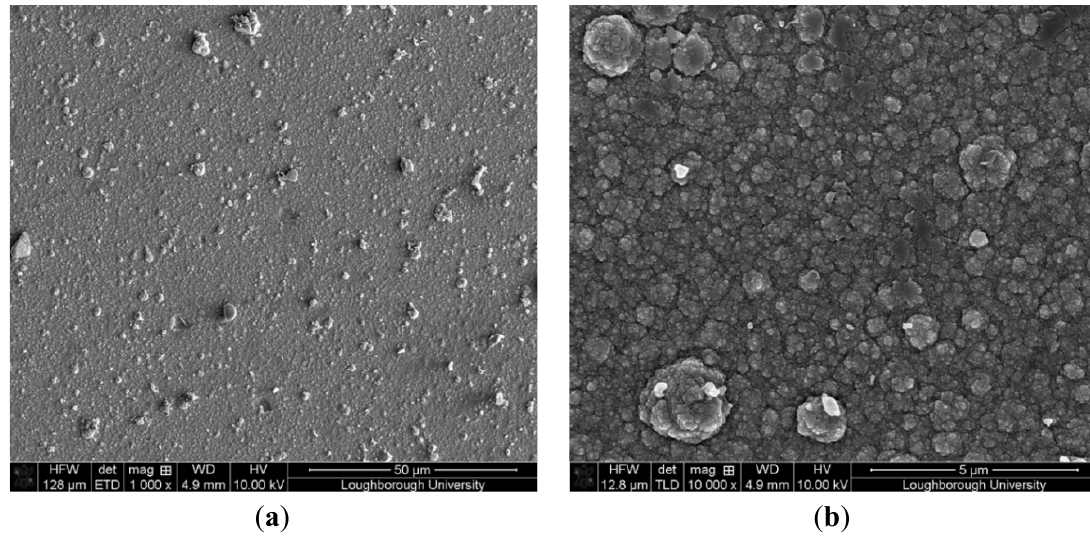
Figure 5. Scanning Electron Microscopy (SEM) images of ED-CdTe layer surface with ( a ) low magnification of ×1000 and ( b ) intermediate magnification of ×10,000 indicating uniform coverage of the